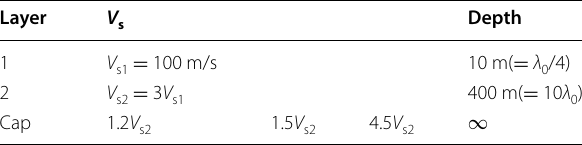
Table 3 Cap‑layered media with different velocities in the cap layer ( V 2 V , density 2.0 g/cm 3 ) p = s =